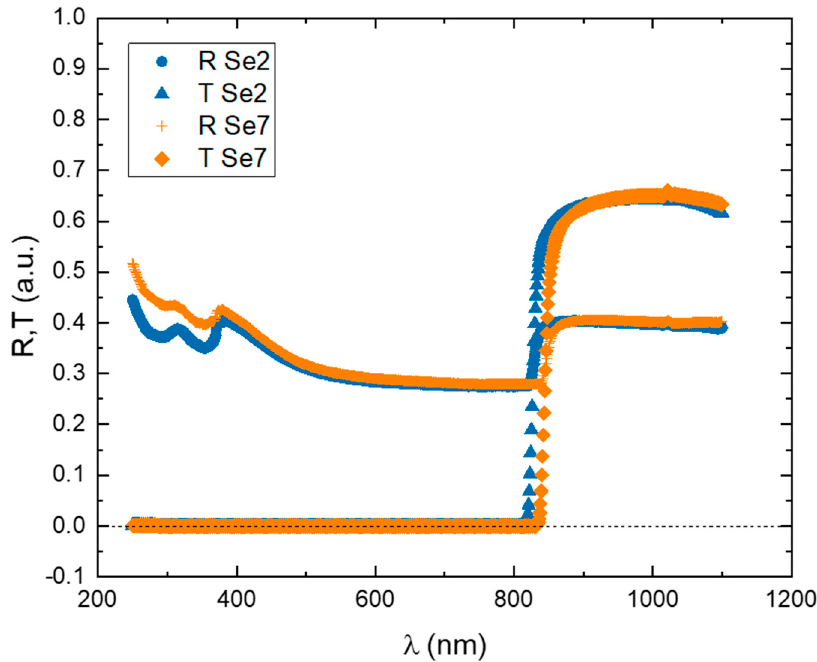
Figure 6. The transmittance and reflectance of the samples at different concentrations of selenium (Se2 and Se7).